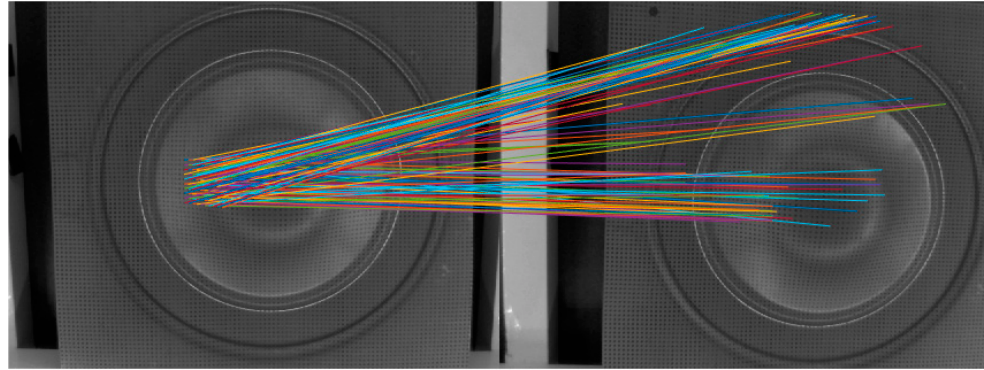
Figure 6. Pairing of points with typical initialization of the Digital Image Correlation.